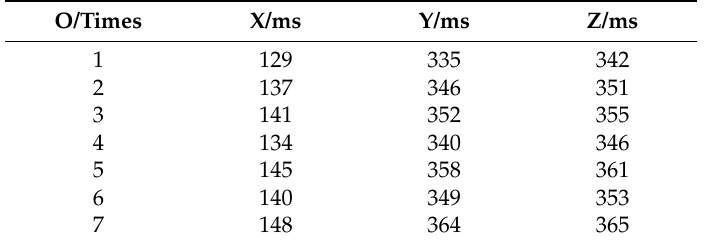
Table 1. Comparison of control completion times for different algorithms.